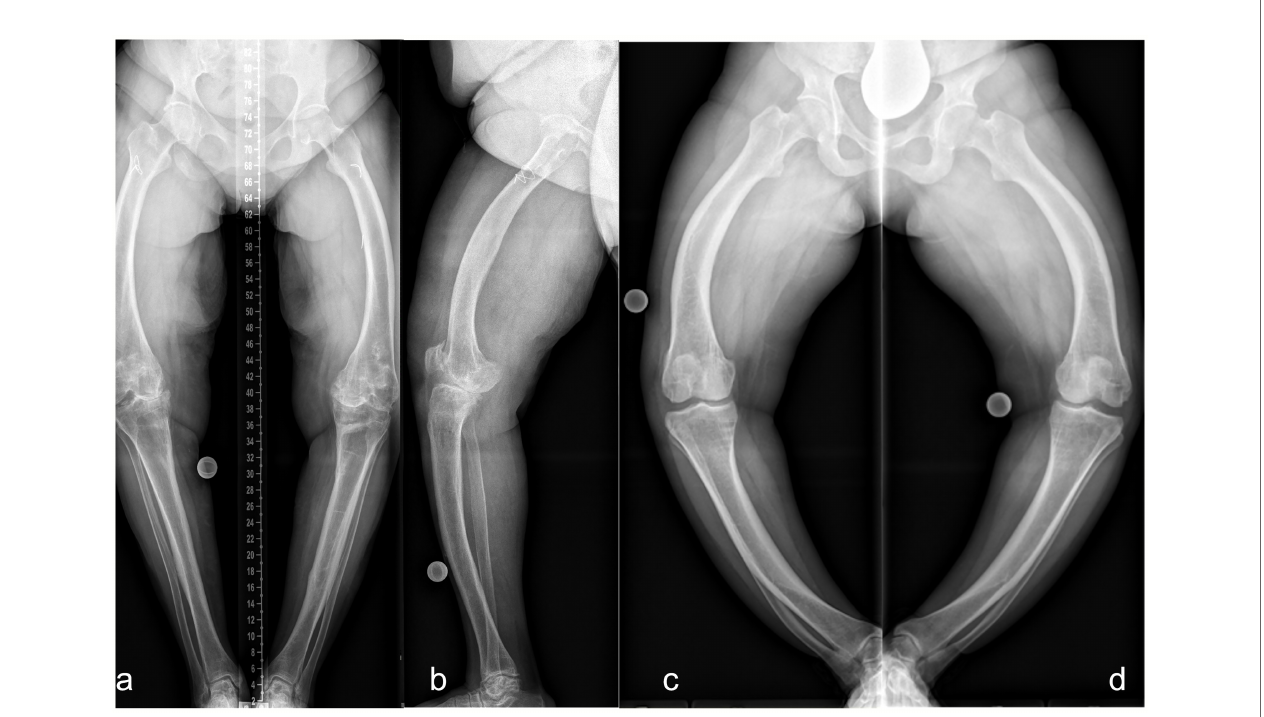
FIGURE 6 | Lower limb deformity of patients prior to surgical frontal plane correction at our hospital. Left ( A frontal, B sagittal): 50 y/o, female, fi ve prior surgeries, GDI: 43.7, BMI: 28.7 kg/m 2 , conventional oral medication. Right: 33 y/o, female, no previous surgeries prior to presentation, GDI: 27.6, BMI: 37.6 kg/m 2 . Full-length anteroposterior radiograph (hip to ankle) of both lower limbs in standing position was not performed due to severe varus deformity. Thus, radiograph image of each leg was taken individually (C, D)